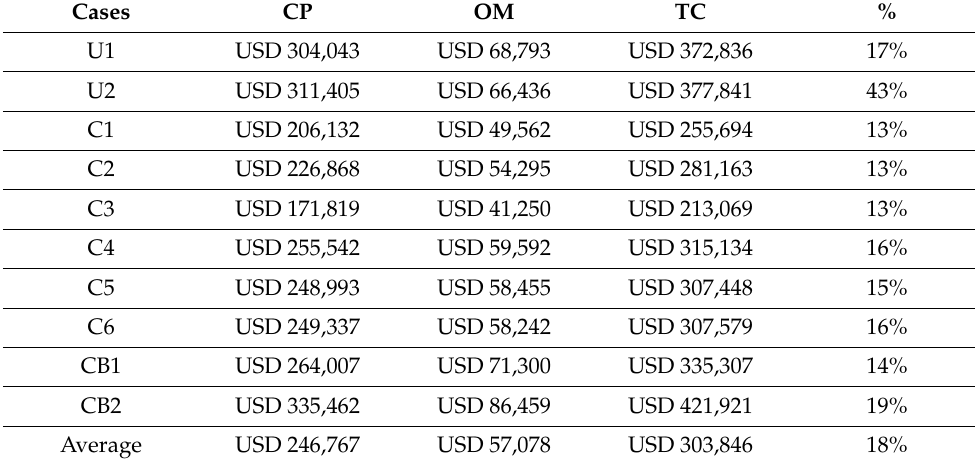
Table 4. Total cost of the selected CSMs for the CCSF. Source: NETL [39–41].